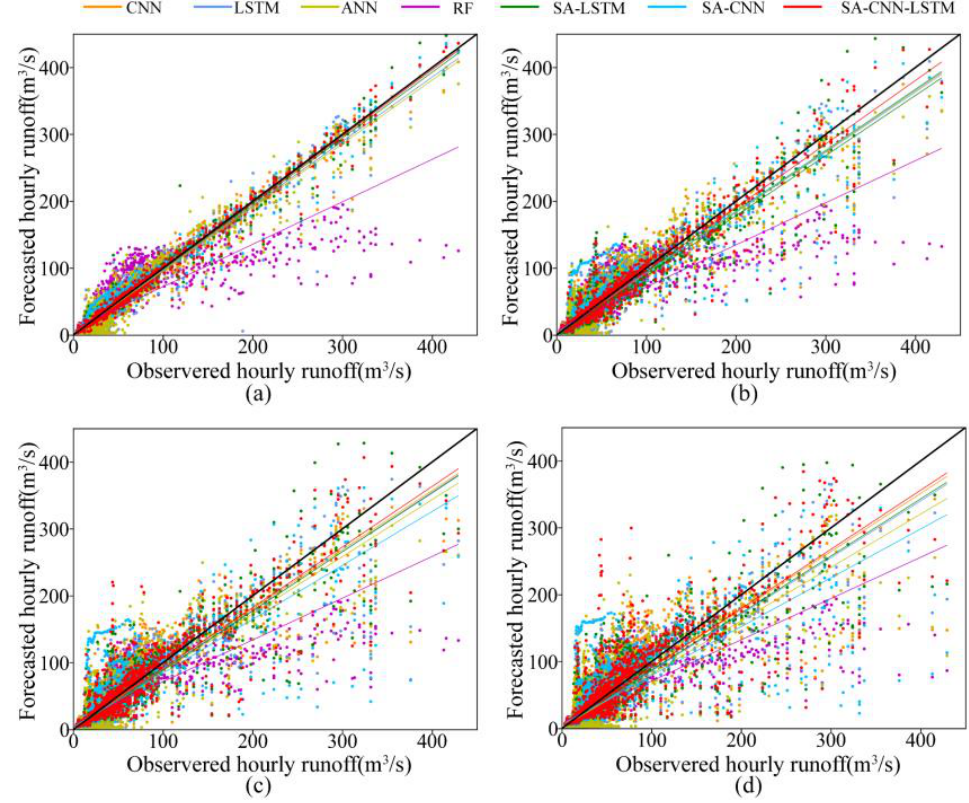
Figure 7. Scatter plots and fitting lines of prediction results for each model at lead times of 1 ( a ), 3 ( b ), 5 ( c ), and 7 ( d ) h.